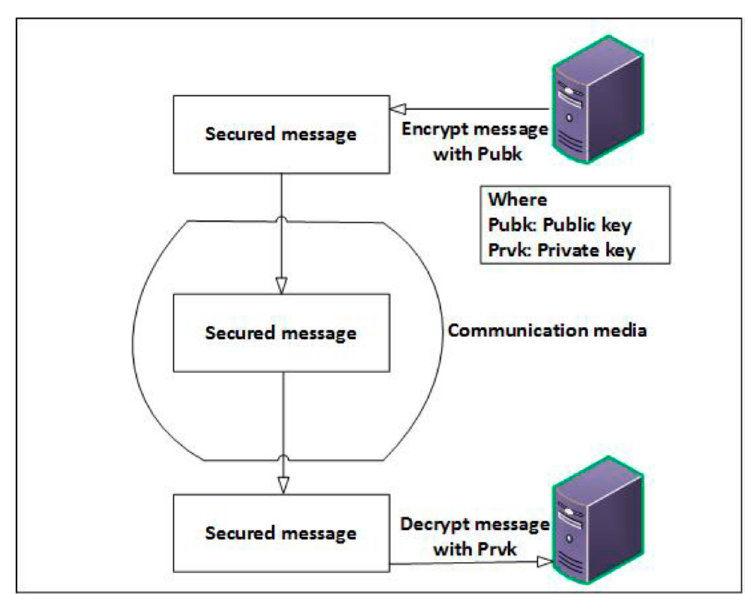
Figure 7. Asymmetric cryptographic approach.